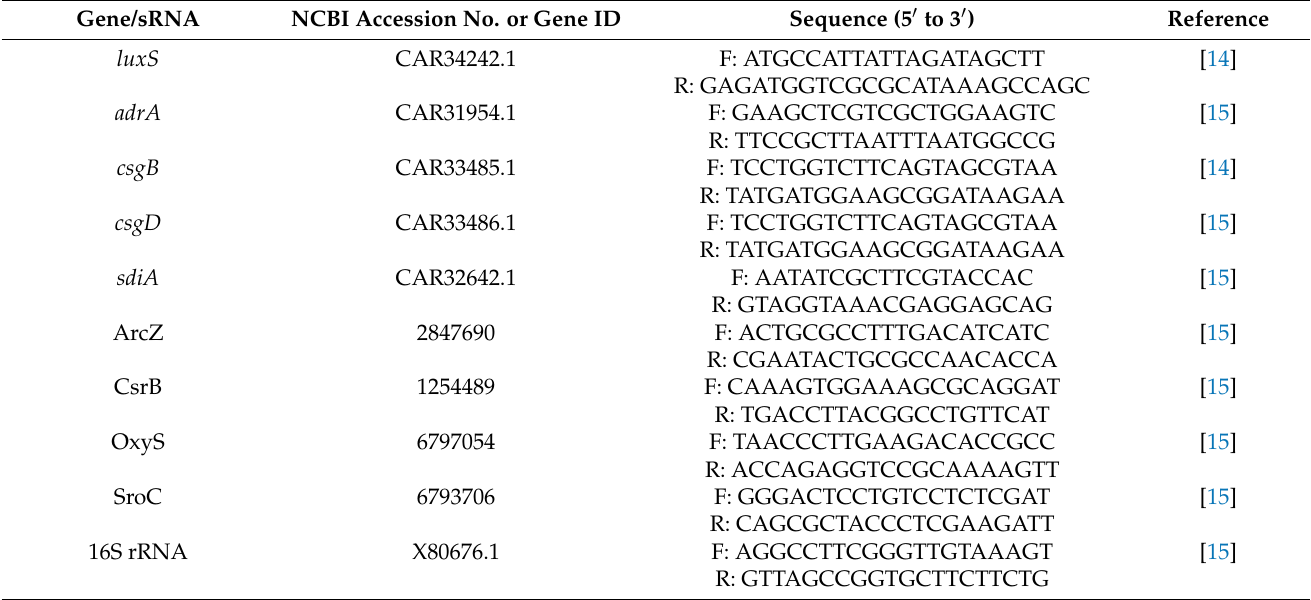
Table 1. Primer sequences of biofilm-related genes and